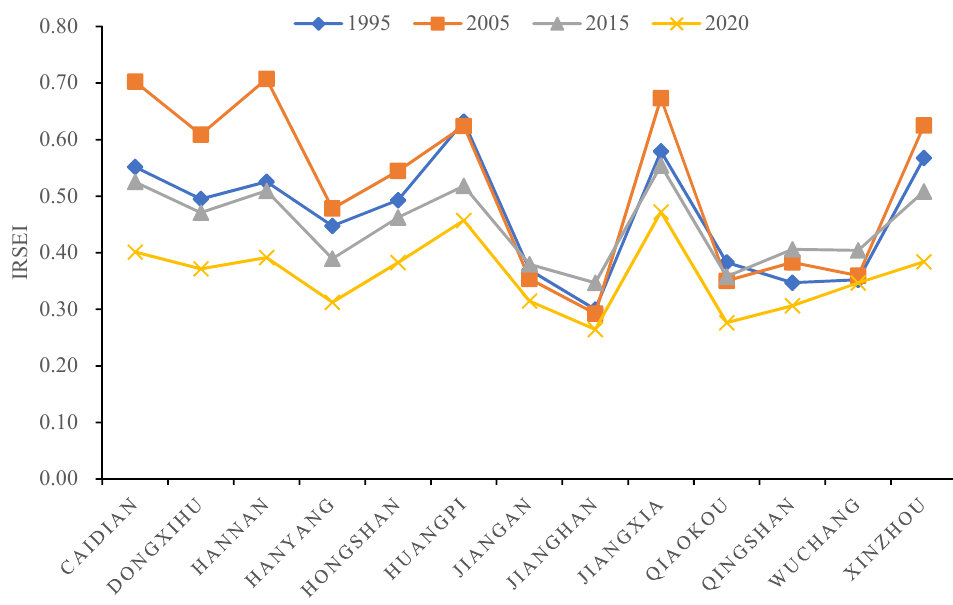
Figure 4. Changing trend of the IRSEI in each district of Wuhan from 1995 to 2020.